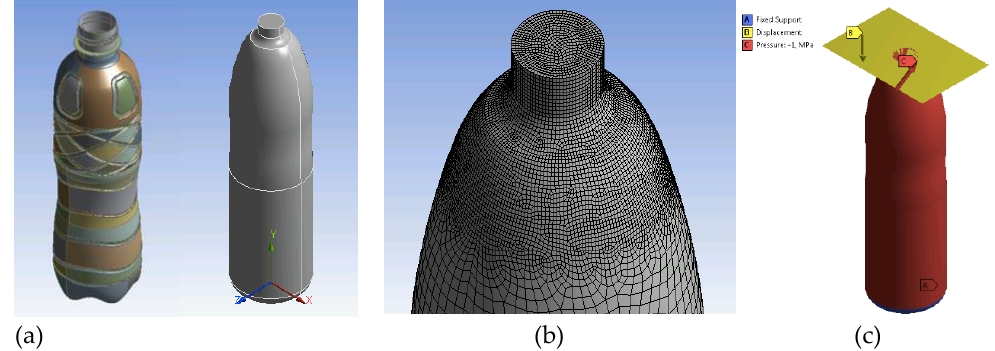
Figure 9. ( a ) Bottle geometry before and after simplification; ( b ) detail of geometry and mesh by shell elements; ( c ) application of forces and boundary conditions (case of non-linear static analysis).